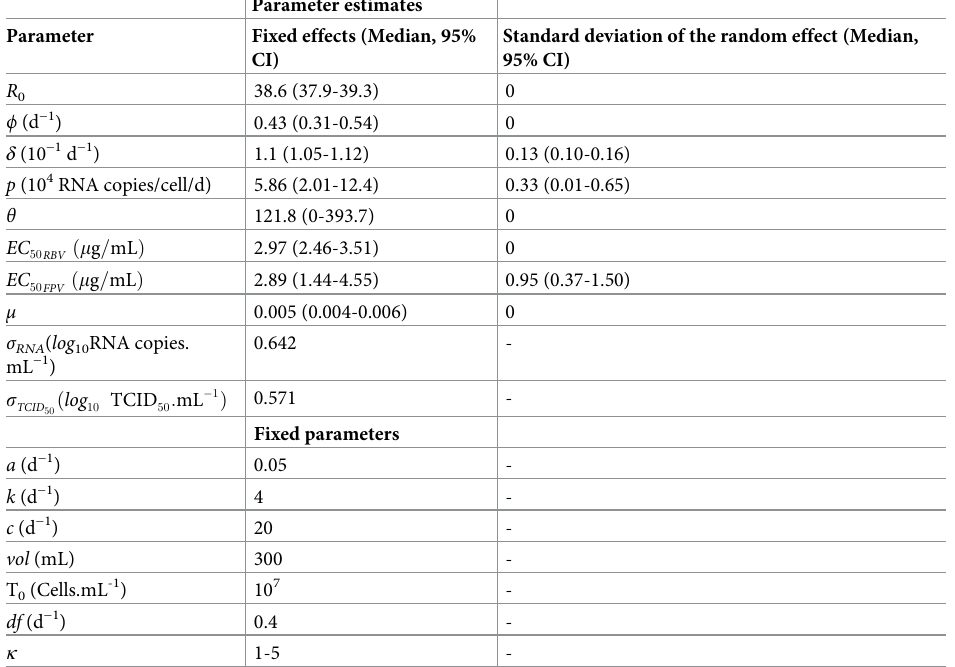
Table 2. Parameters distribution using model averaging (Median, 95%